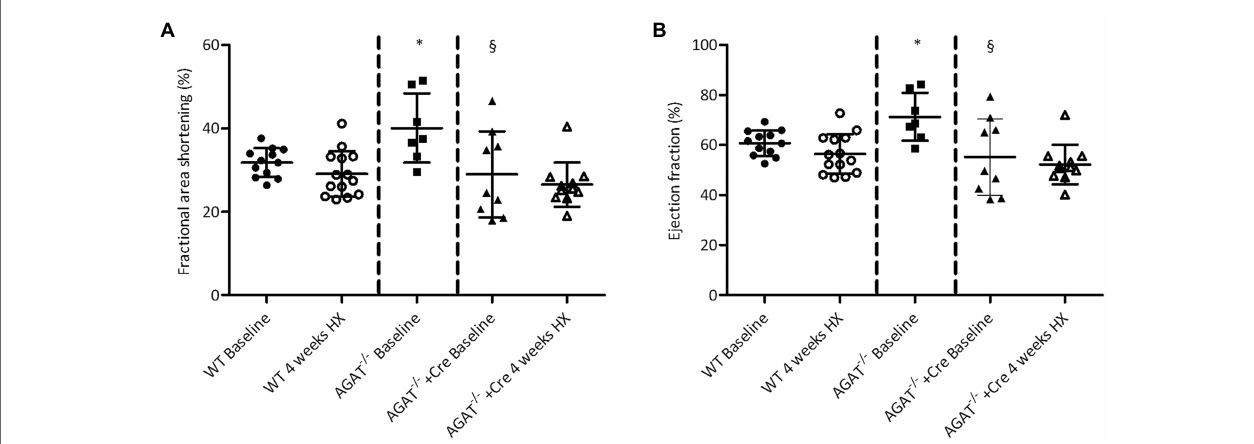
FIGURE 5 | Echocardiography of Agat − / − mice and WT littermates. (A,B) B-mode images were obtained in a parasternal short- and long-axis view, and dimensions of the left ventricle were measured in a short-axis view in diastole and systole from Agat − / − mice supplemented with 1% creatine and WT littermates (WT) at baseline and after 4 weeks of hypoxia (HX). Mean values ± SD are presented. (A) Fractional area shortening. (B) Ejection fraction. Agat , arginine:glycine amidinotransferase; Cre, supplemented with 1% creatine. * p < 0.05 vs. WT baseline, § p < 0.05 vs. Agat − / − baseline (ANOVA with Bonferroni post-hoc